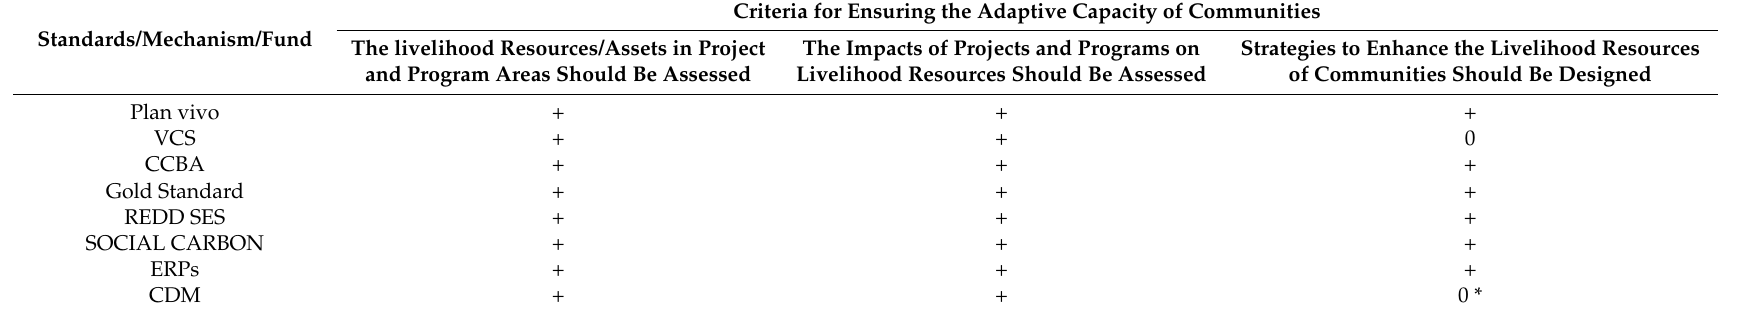
Table 3. Ensuring the promotion of adaptive capacity of communities in the guidelines for developing forest carbon